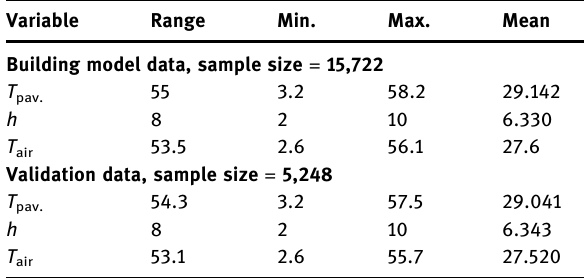
Table 4: Data limitations used in the